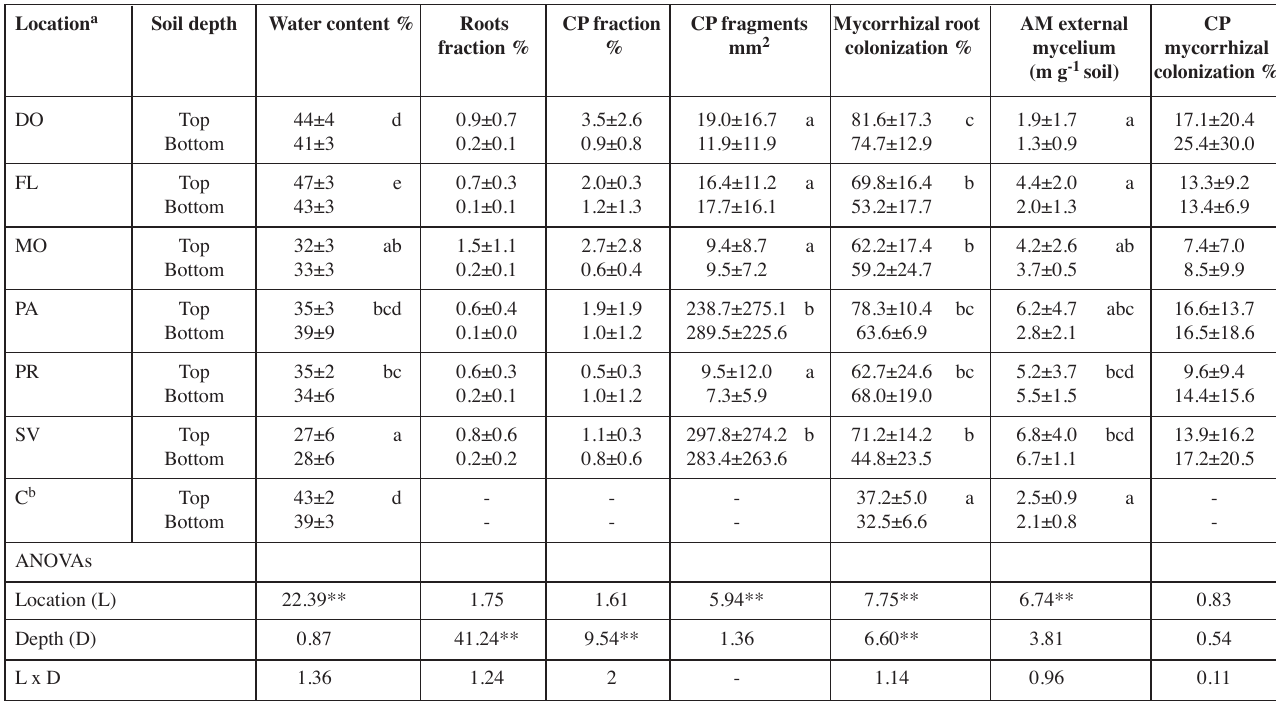
Tab. 2: Soil water content, fraction of roots and coffee pulps (CP) in soils, area of CP fragments, and mycorrhizal parameters investigated in top layer (0-5 cm) and bottom layer (5-10 cm) at different locations of Caquetá, Colombia. Location a Soil depth Water content